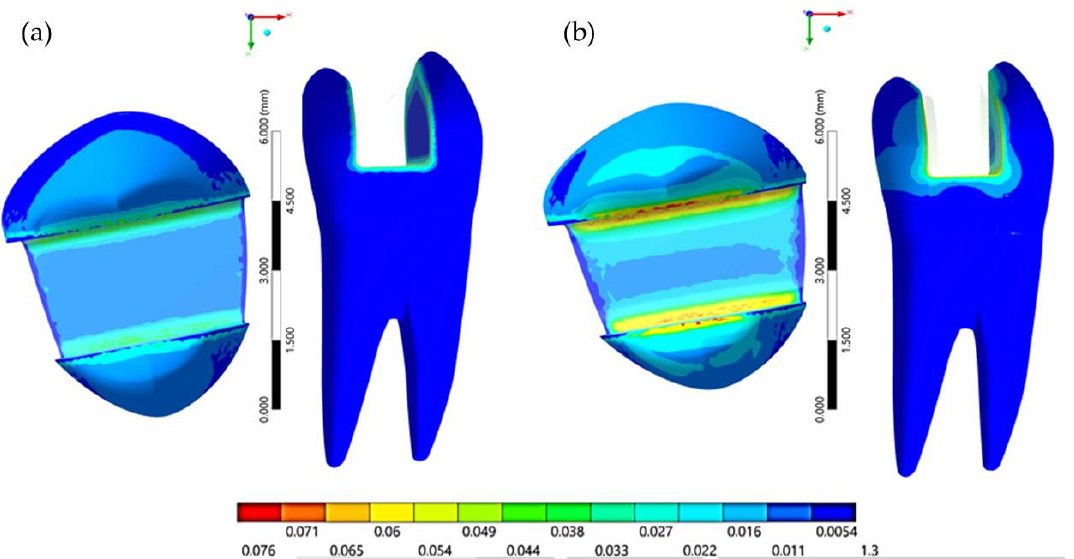
Figure 5. Maximum principal stress in the tooth with ( a ) 100 μm cement thickness model and ( b ) 400 μm cement thickness.